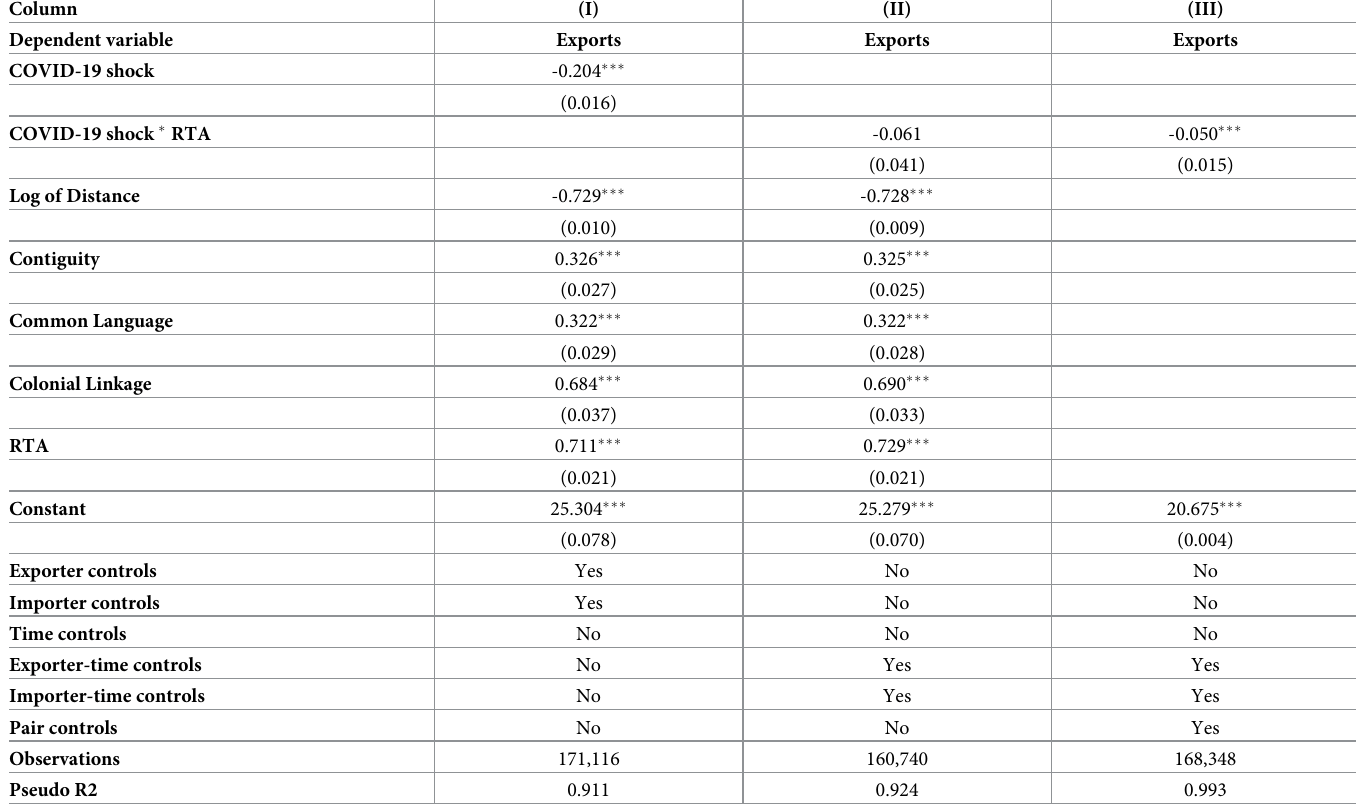
Table 2. Robustness of gravity estimators estimated by PPML, January 2019-October 2020.